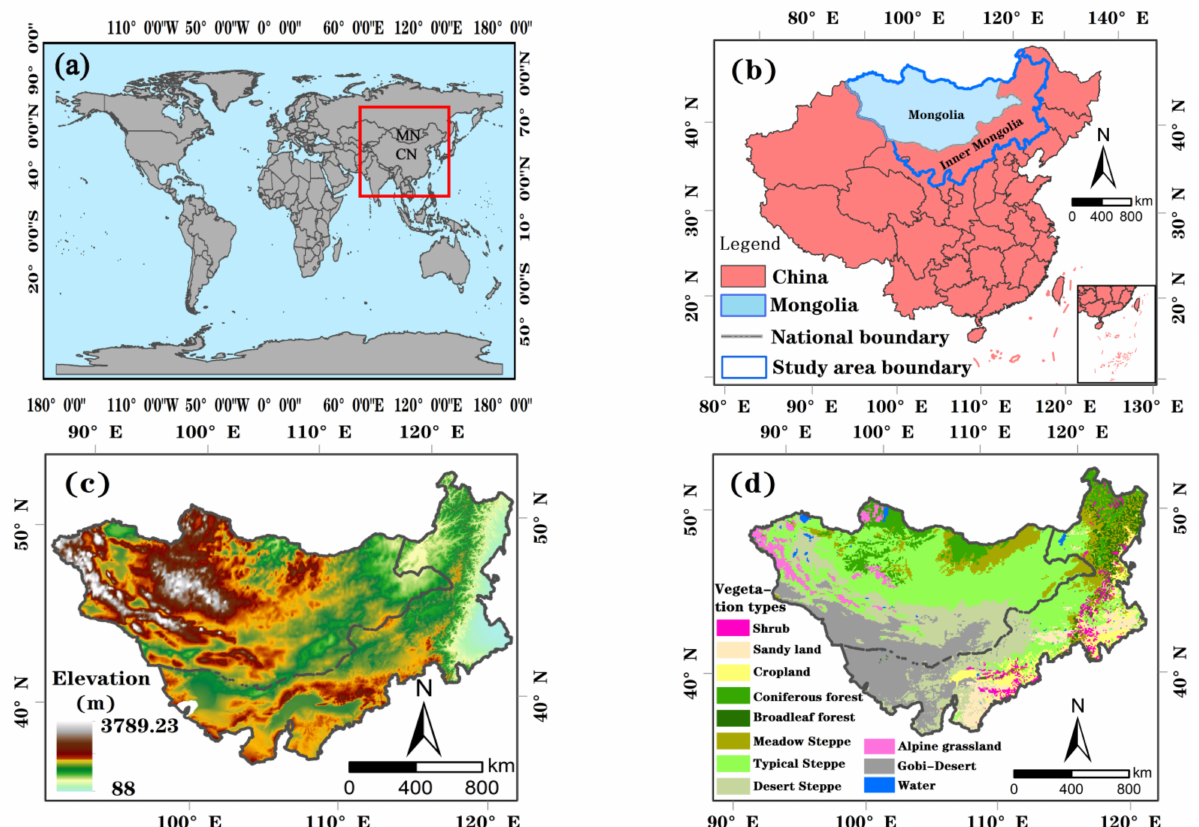
Figure 1. Geographic characteristics of the Mongolian Plateau: ( a , b ) geographical location of study area, ( c ) elevation, ( d ) vegetation